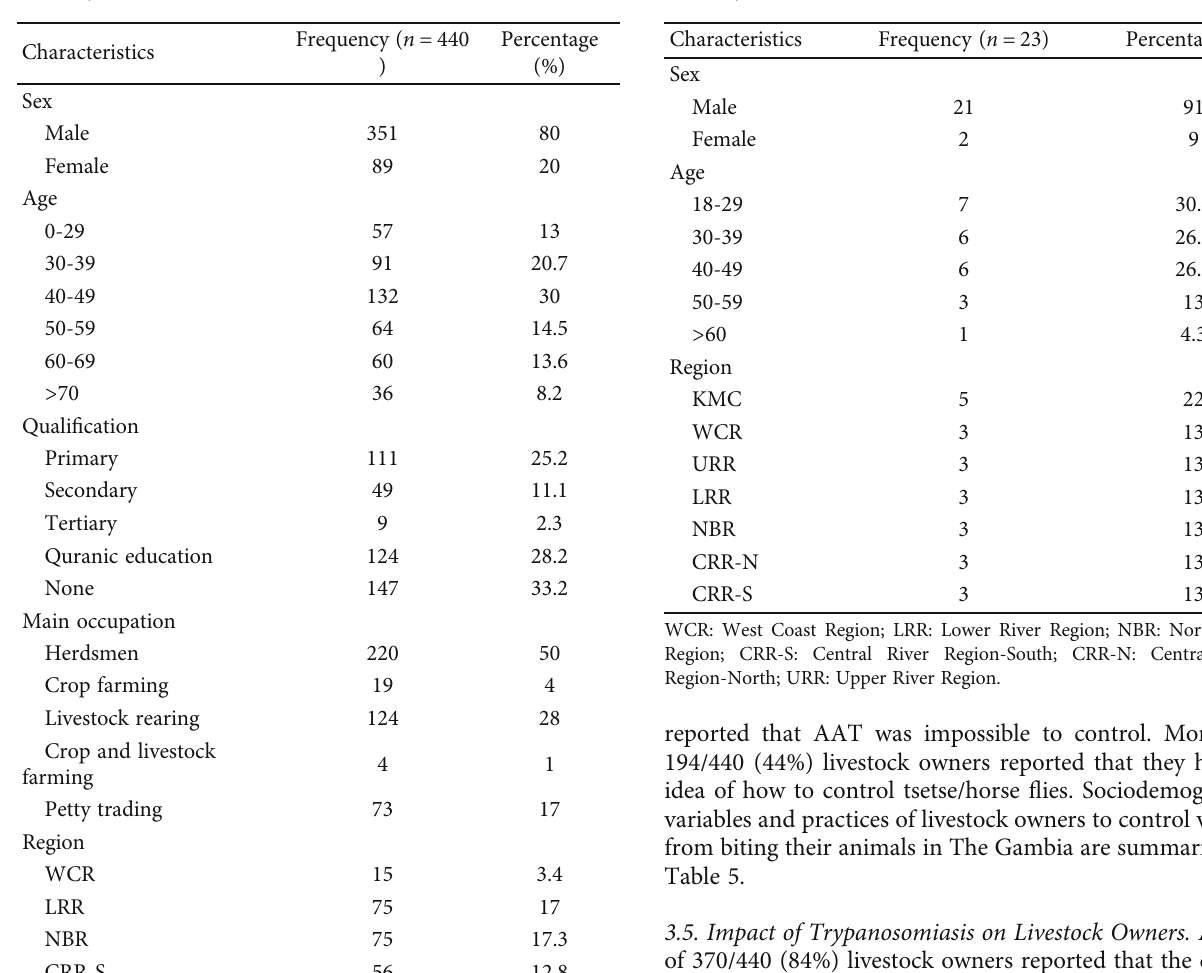
Table 1: Sociodemographic pro fi le of livestock owners from The Gambia, 2021.